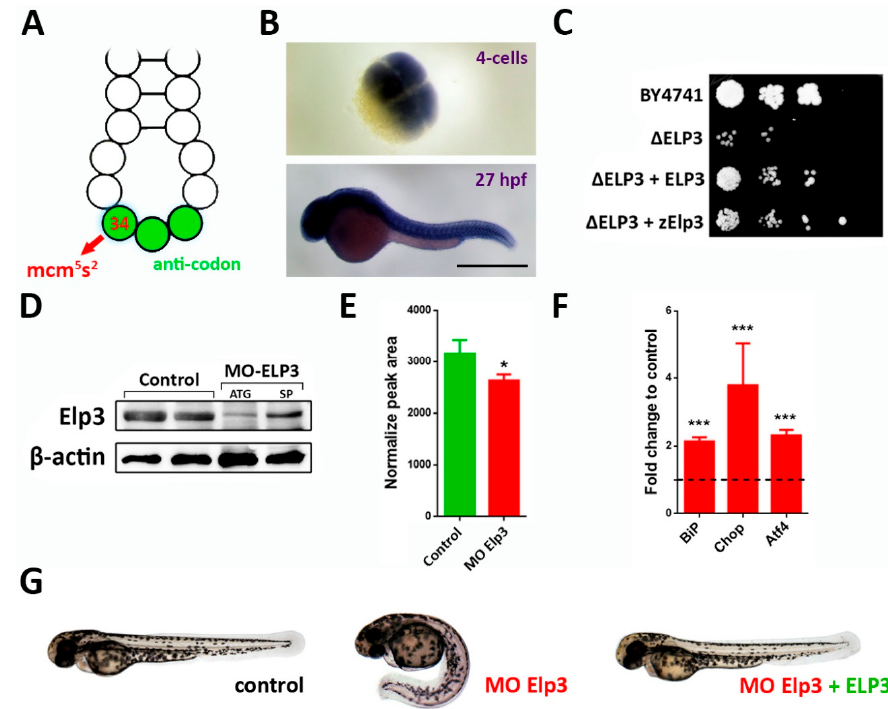
Figure 1. Elp3 morphants present a ventrally-curved tail. ( A ) Schematic representation of the anti-codon loop of a tRNA, indicating position 34 (red arrow) where 5-methoxycarbonylmethyl-2-thiouridine (mcm 5 s 2 U) is located. Anti-codon is depicted in green. ( B ) In situ hybridization of Elp3 mRNA in 4 cell (upper) and 27 hpf (lower) embryos. Scale bar 0.7 mm. ( C ) Saccharomyces cerevisiae mutants for ELP3 ( Δ ELP3) were transformed with an expression plasmid that contained zebrafish Elp3 (zElp3). BY4741 was used as control. Image representative of three independent experiments. ( D ) Western blot detecting Elp3 in 48 hpf samples from control and morphant embryos (MO-Elp3); β -actin was used as loading control. Samples from embryos injected with translation- (ATG) and splicing-blocking (SP). ( E ) Liquid chromatography-mass spectrometry (LC-MS) analysis of tRNA modification. Peak area values for mcm 5 s 2 U are shown normalized to the of purified tRNA for each sample ( n = 3, * p < 0.05). ( F ) qPCR for UPR targets BiP, Chop and Atf4. Fold change in mRNA levels comparing morphant embryos to controls; t-test was performed for statistical analysis. *** p < 0.005). ( G ) Representative images of control, morphants and MO + ELP3 mRNA injected embryos by 48 hpf (images representative of at least six independent experiments, in which at least 100 embryos were